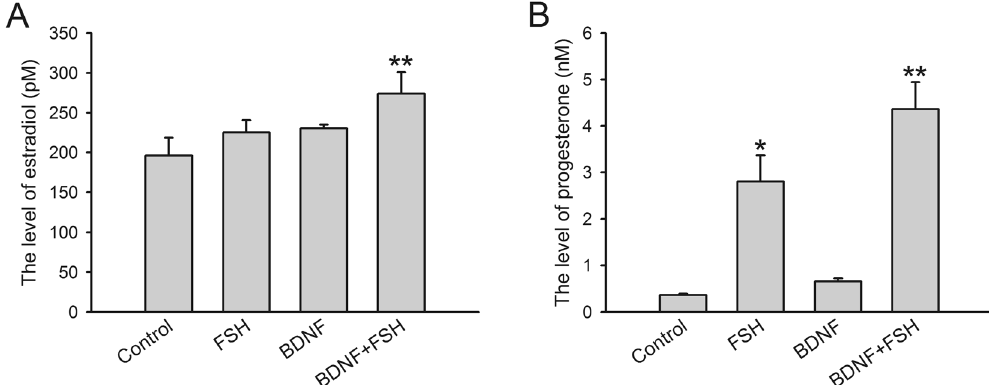
Figure 2. Estradiol and progesterone secretion in KGN cells after treatment. KGN cells were treated with FSH (100 ng/ml), BDNF (5 ng/ml) and FSH (100 ng/ml) plus BDNF (5 ng/ml), respectively, for 24 h. Production and secretion of estradiol ( A ) and progesterone ( B ) were detected by the chemiluminescent immunoassay system. * P < 0.05 and ** P < 0.01 versus control group.